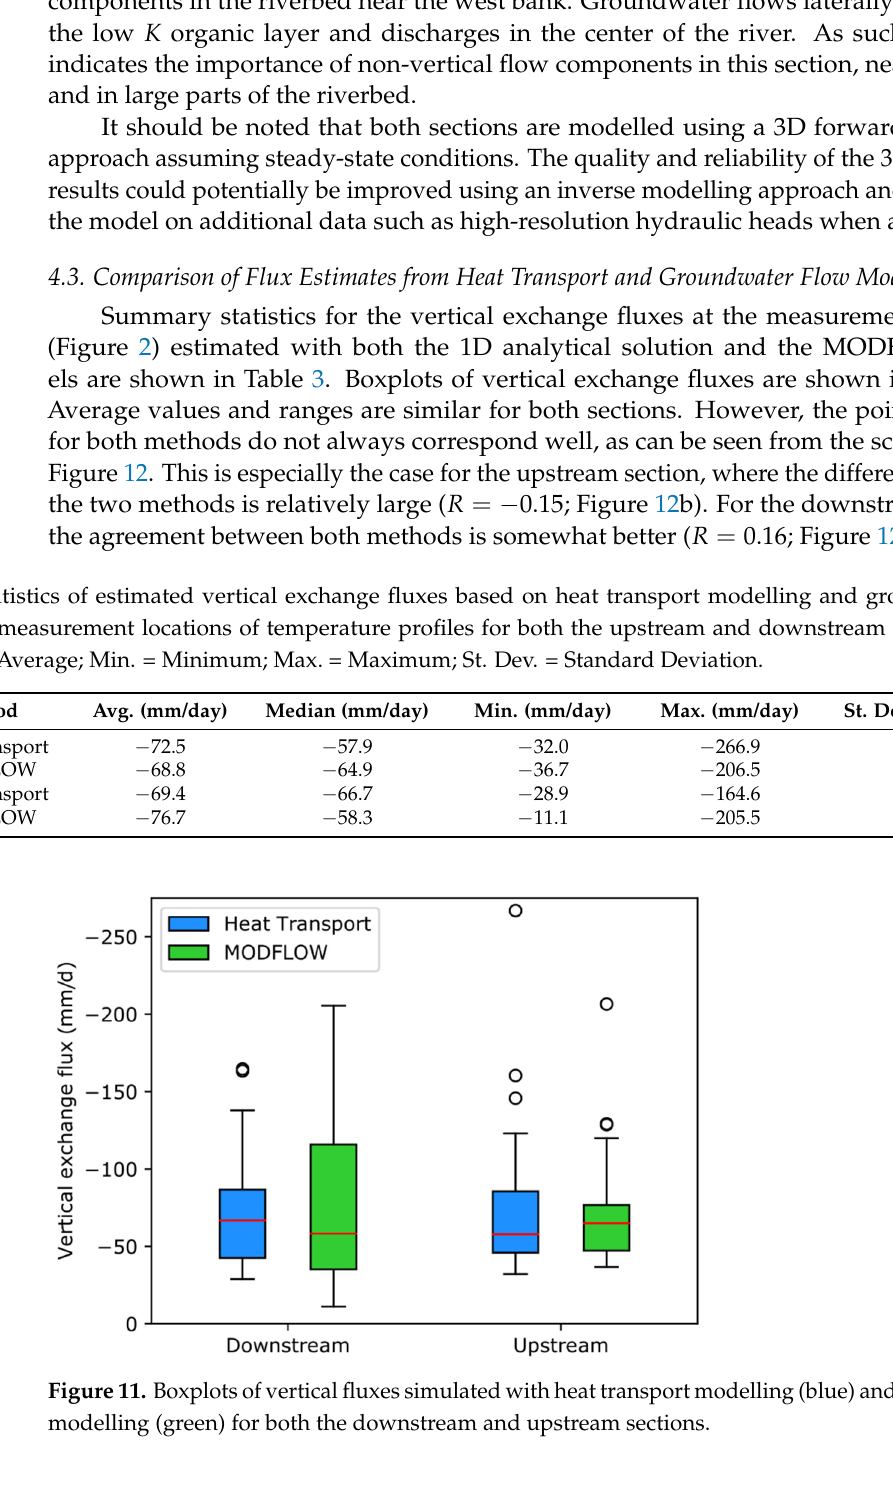
( b ) Figure 12. Scatterplots of simulated vertical flux estimates based on heat transport versus groundwater modelling for ( a ) the downstream section (R = 0.16) and ( b ) the upstream section (R = − 0.15). The black line is the one–one line. Based on the spatially distributed maps of exchange flux for both the upstream and downstream sections and both methods (Figures 4e,f, 7, and 9), the total exchange flux averaged over the respective area of these sections can be calculated. For the downstream section, the total flux based on the kriging map of 1D flux estimates using the heat transport model is − 74.4 mm/day (Figure 4e) while the flux simulated with the groundwater model is − 133.7 mm/day (Figure 7). Expressed in volumetric fluxes, this corresponds to − 40.9 m³/day and − 73.5 m³/day, respectively (Figure 13). For the fluxes simulated with the groundwater model, vertical fluxes through the riverbed contribute − 49.3 m³/day, while lateral flows through the riverbanks account for − 24.2 m³/day or